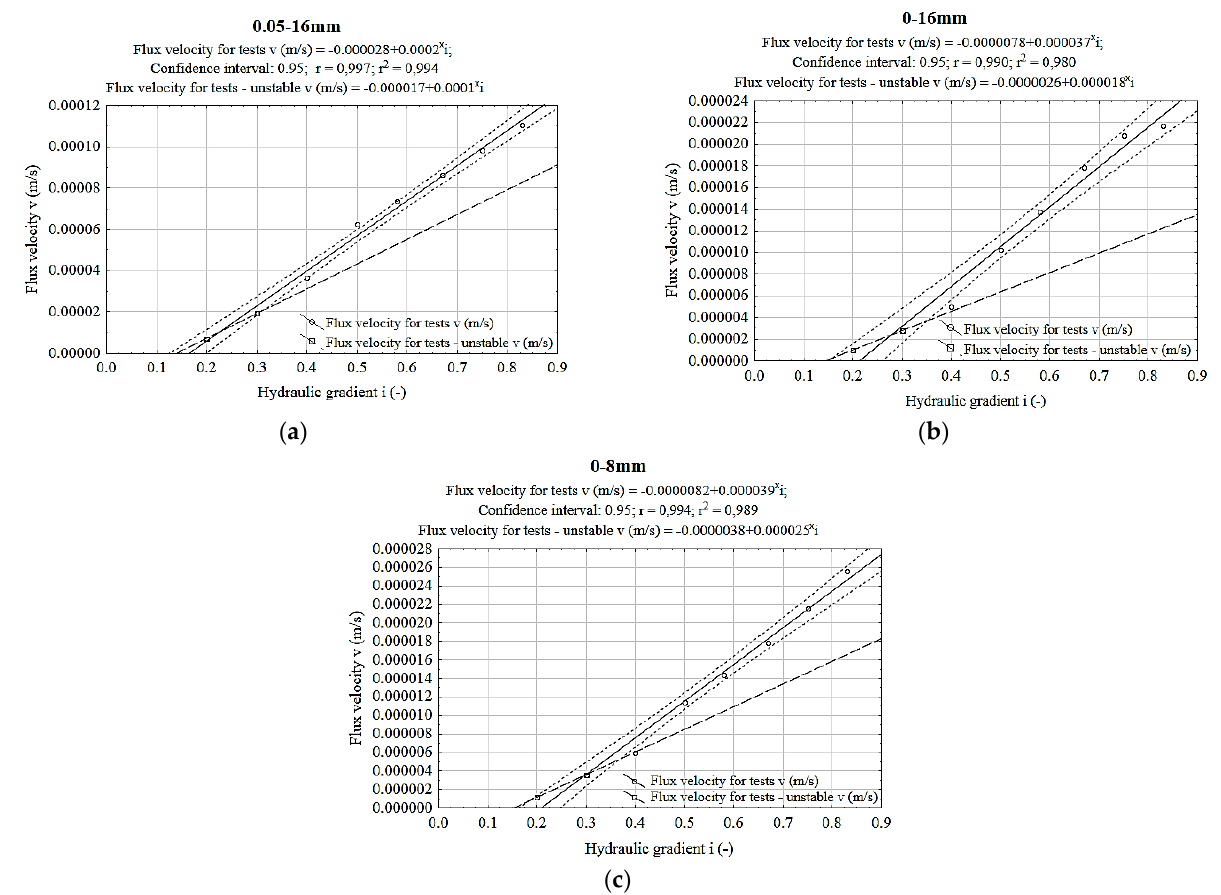
Figure 8. Relation between the flux velocity and the hydraulic gradient with unstable tests for the blends. ( a ) blend 0.05–16 mm; ( b ) blend 0–16 mm; ( c ) blend 0–8 mm.